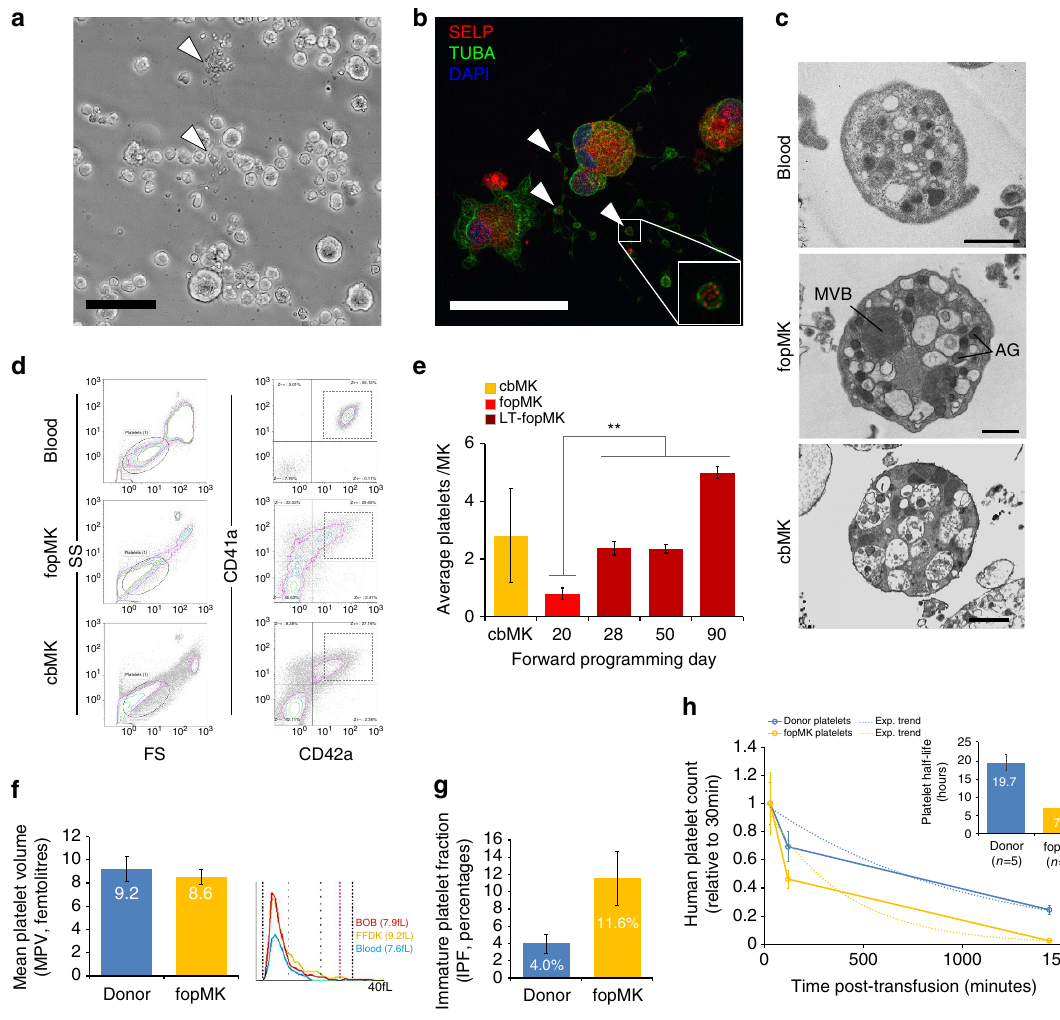
Figure 5 | Platelet release in vitro from fopMKs throughout long-term culture. ( a ) Phase contrast picture of spontaneous proplatelet-forming fopMKs (arrowheads) in suspension culture (hiPSC#3, day26; scale bar, 50 m m). ( b ) Proplatelet-forming fopMK on fibrinogen-coated slide immunostained for alpha-tubulin (TUBA) and P-selectin (SELP). Arrowheads indicate nascent platelet tips containing SELP-positive granules (hiPSC#4, day21; scale